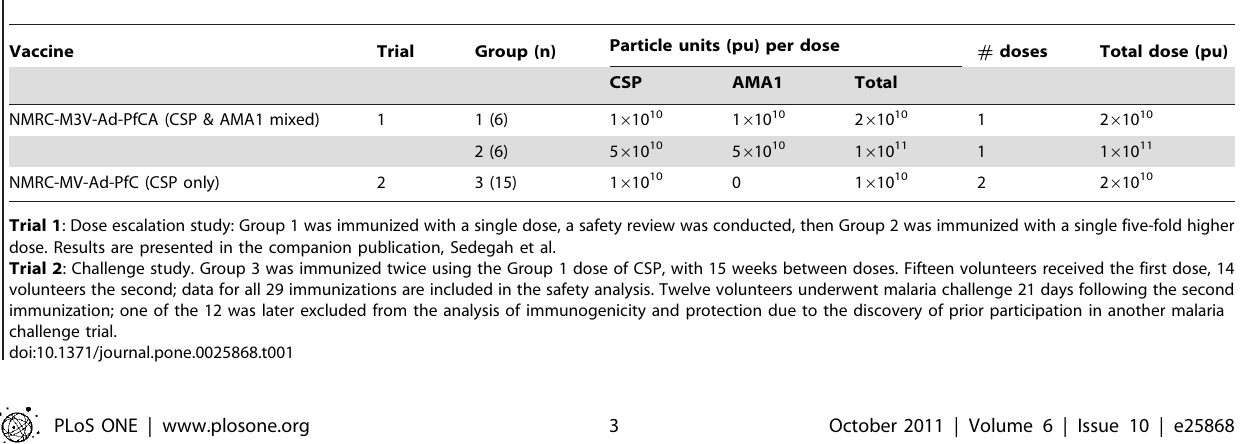
Table 1. Vaccine constructs, doses, and times of immunization.